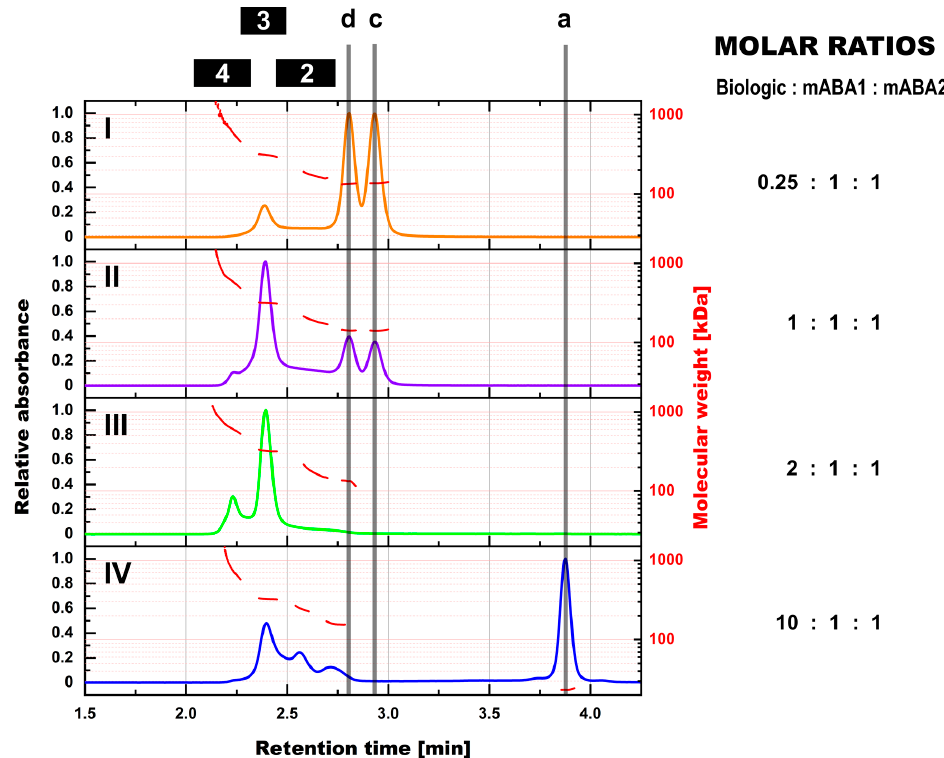
Figure 2. SEC-MALS assessment of formed immune complexes in PBS and the impact of the molar ratio between biologic and mABAs. Normalized SEC-UV profiles are shown for bio- logic:mABA1:mABA2 compositions of the following molar ratios—0.25:1:1 on panel ( I ), 1:1:1 on panel ( II ), 2:1:1 on panel ( III ), and 10:1:1 on panel ( IV ). Molecular weight profiles of detected im- mune complex species from MALS analyses are shown by scatter points in red. Marker: (a) free Biologic, (c) free mABA1, (d) free mABA2, (2) immune complexes with a single ABA incorporated, (3) immune complexes with two incorporated ABAs, (4) immune complexes with more than two incorporated